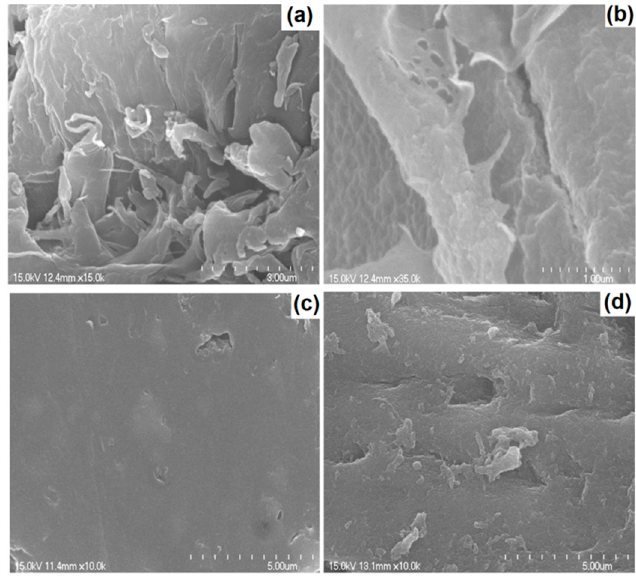
Figure 3. SEM micrographs of ( a ) chitosan, ( b ) DMC, ( c ) QPSf/DBB, and ( d ) quaternized PSf composited with 2 wt% N , N -dimethyl chitosan (QPSfDMC2).